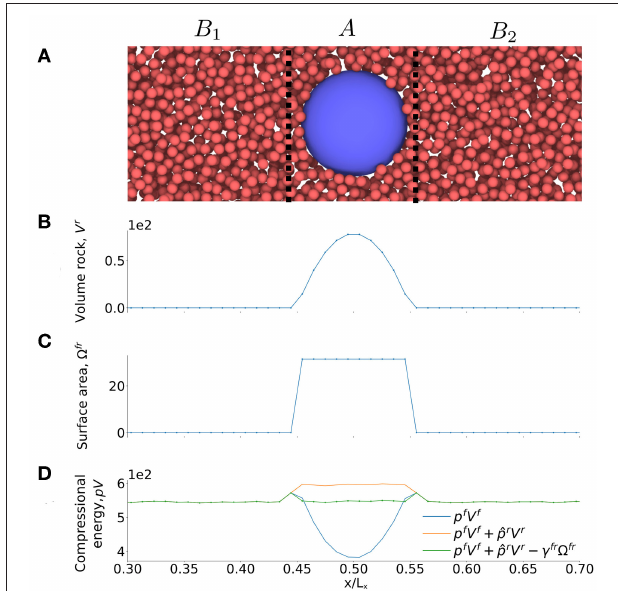
FIGURE 4 | (A) Illustration of case I, a single spherical grain surrounded by a fluid phase with d 4 σ 0 . (B) Volume of grain, V r , (C) surface area (cid:127) fr and (D) = compressional energy pV as a function of the x -axis of the simulation